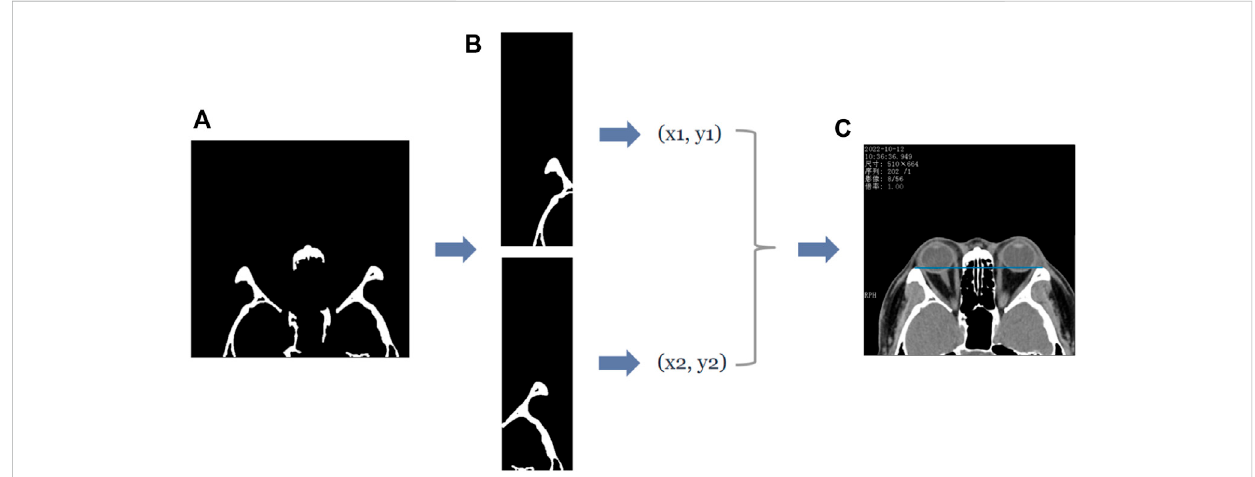
FIGURE 4 TheprocessofobtainingthecoordinatesofthemostprotrudingpointofthelateralorbitalrimofbotheyesintheaxialplaneoftheCTimage. (A) First row of Panel (B) , which is the binary image containing the lateral orbital rim region of both eyes. Subsequently, the coordinates of the most protruding points (x1, y1), (x2, y2) of the left and right lateral orbital rims can be determined by traversing the two subgraphs separately, and the straight line passing through the two most protruding points can be visualized by the blue line in (C) .